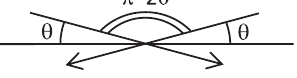
FIG. 2. Collision